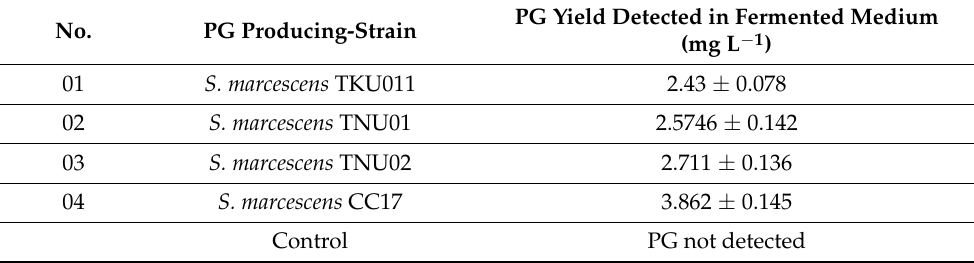
Table 1. The conversion of SHP into PG by various bacterial strains of S. marcescens. PG Yield Detected in Fermented No. PG Producing-Strain